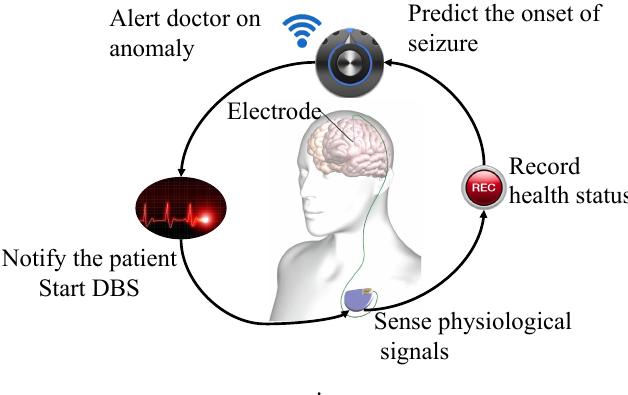
Figure 1. Example of a schematic flow of closed loop operation of the DBS process. Inclusion of the expert is always in loop before any treatment is applied locally. Picture adapted under CC BY 3.0 license from